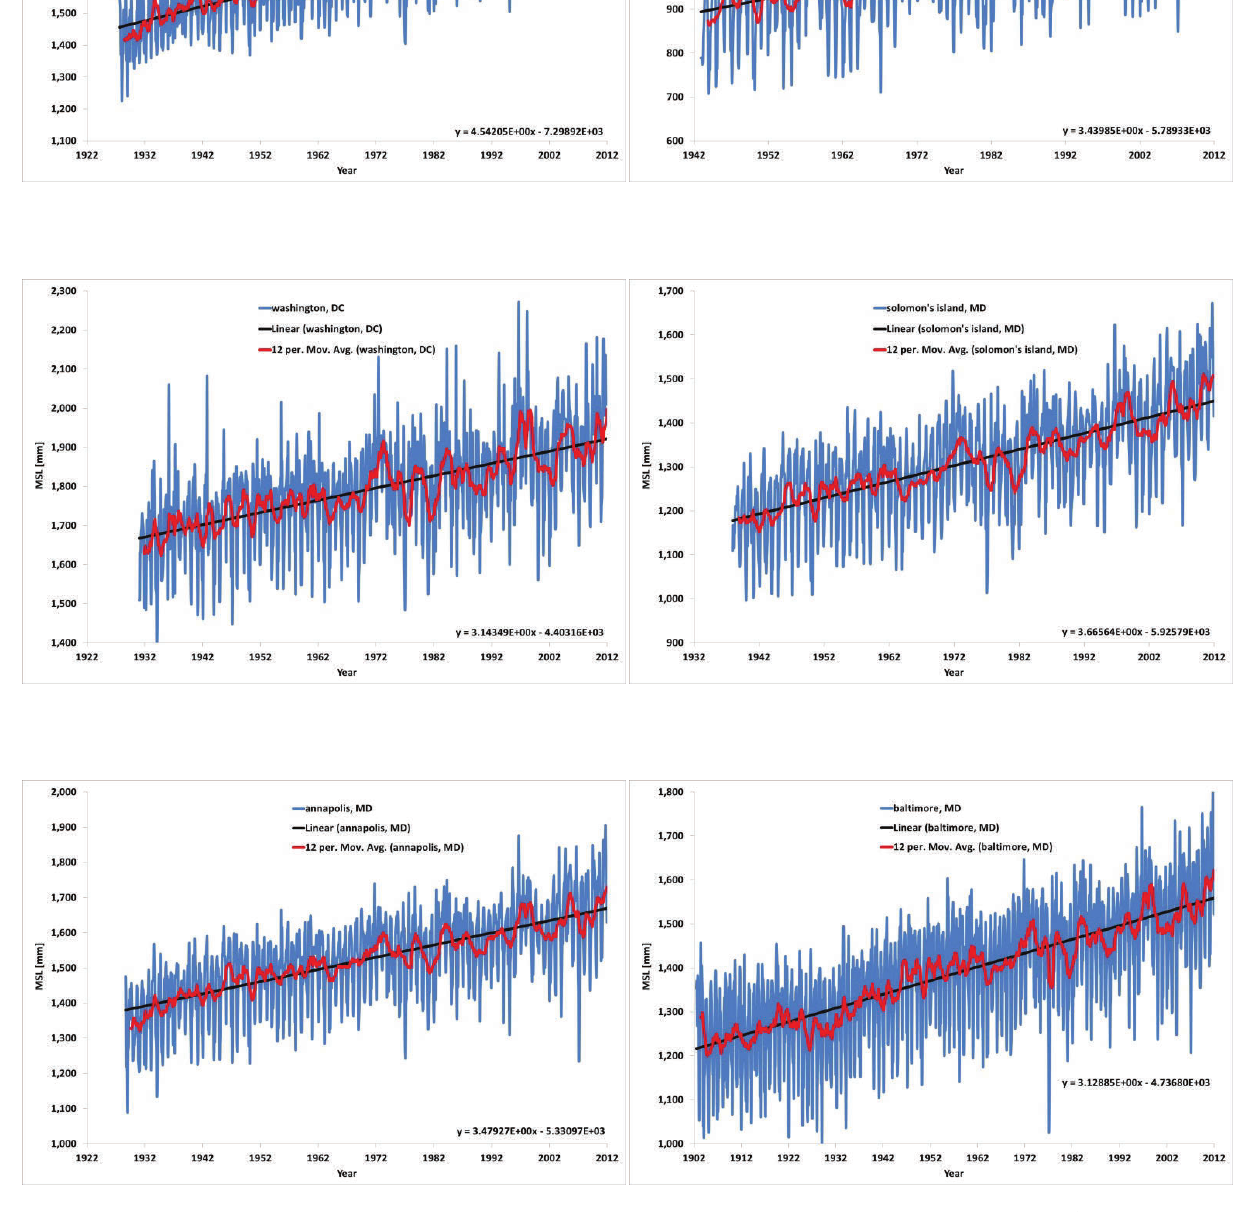
Figure 3. Latest SLR A for the 6 stations in Maryland, Virginia and District of Columbia with more than 65 years of recording at the present time. These values are correctly estimated by using a proper time window. (data from [12]; pic- tures from